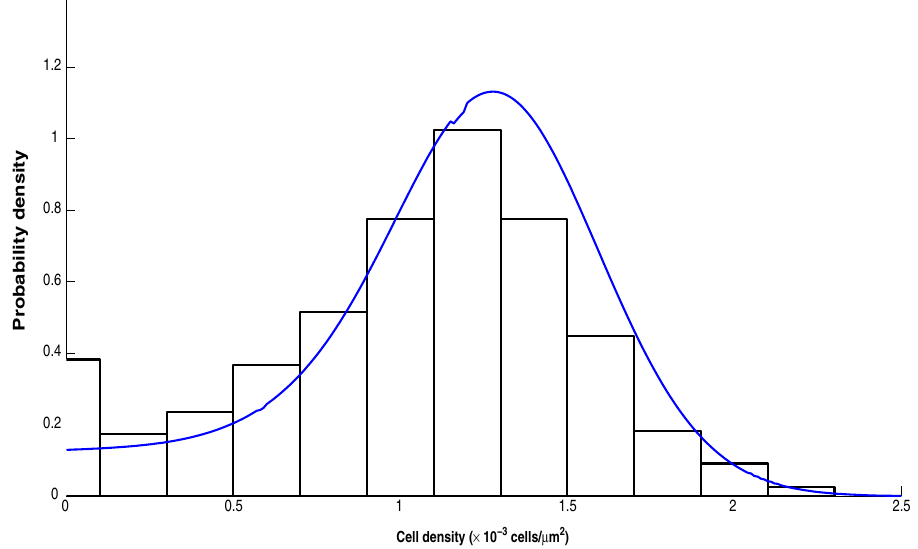
Figure 7. The histogram shows the distribution of cell densities at steady state under additive and multiplicative noises. The blue curve is the SSPDF. The function SSPDF and the distribution of cell densities matches to each